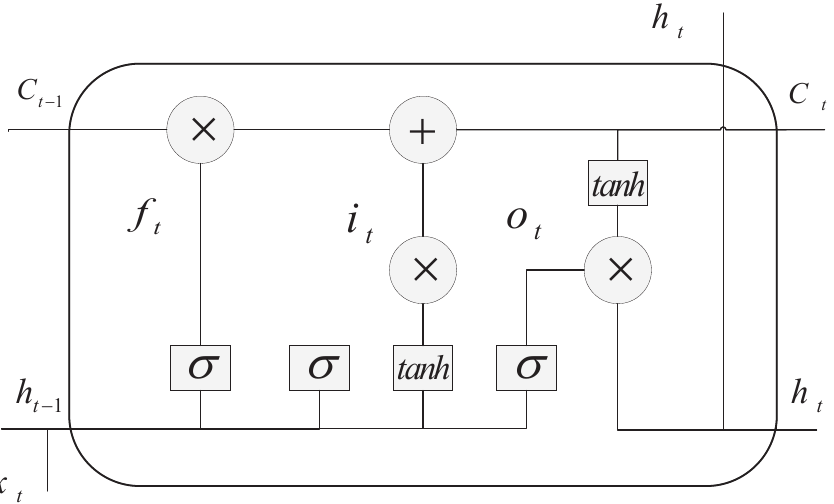
Figure 2. The internal structure of long short-term memory unit.